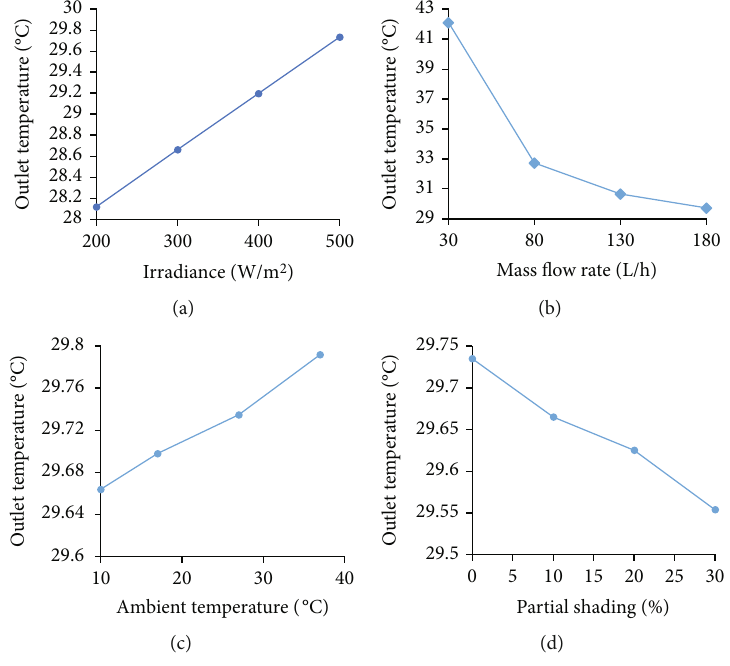
Figure 15: Outcome of (a) G , (b) V